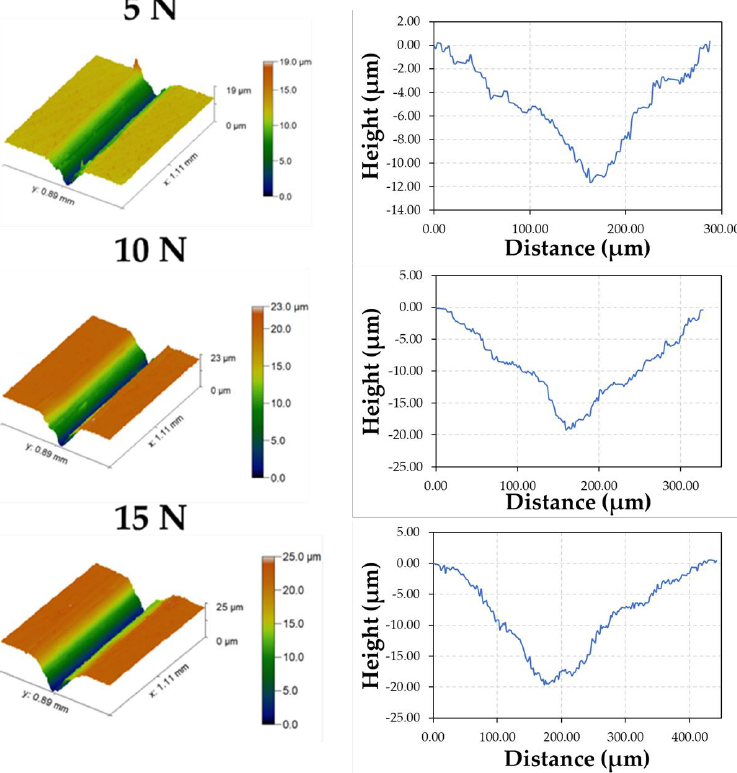
Figure 16. The wear tracks of the Zr coated specimen S3 under the normal loads of 5, 10, and 15 N.